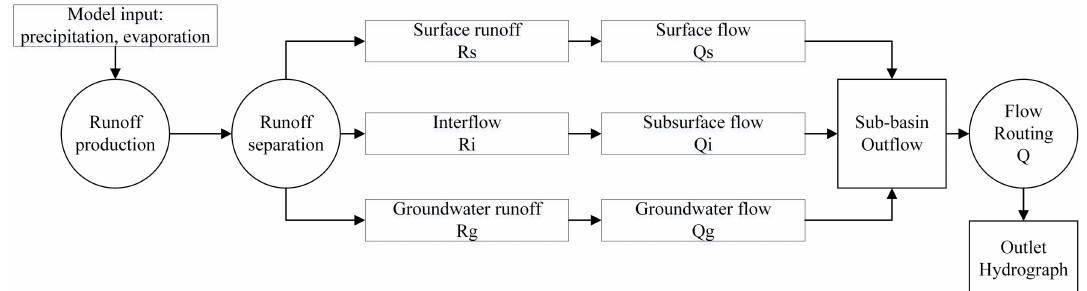
Figure 3. Xinanjiang (XAJ) model flow-chart [46].